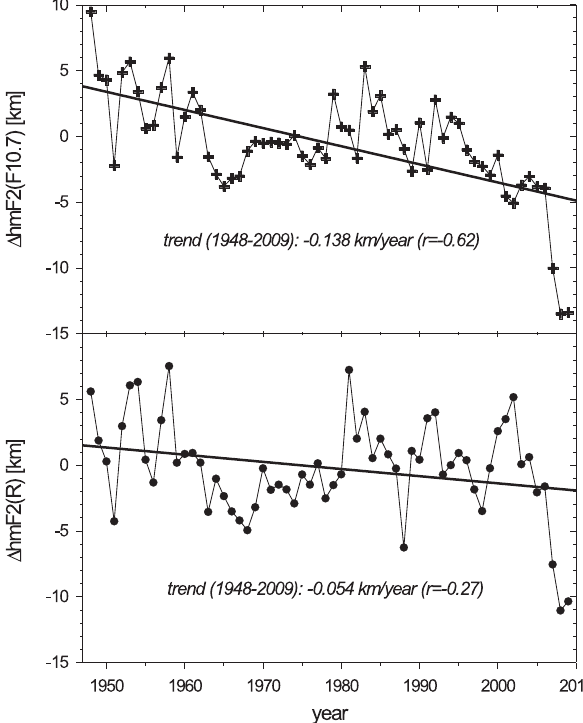
Fig. 5. Global mean hm F2 trends by use of F10.7 (upper part) or R data (lower part) in the trend